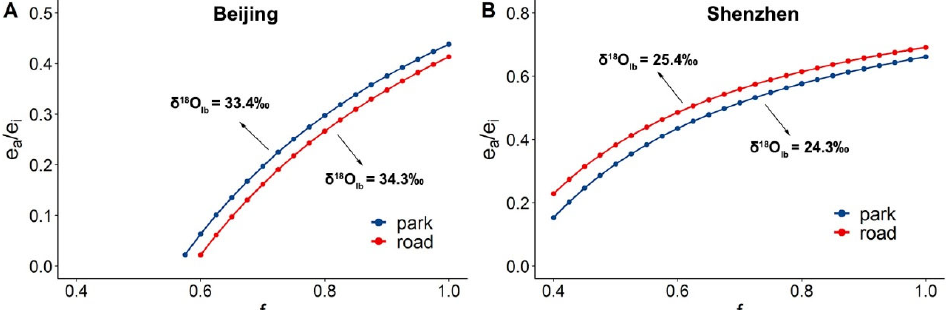
Figure 6. Relationship between δ 18 O in leaves and e a /e i under different green land types ( A ) P. tomentosa leaves in Beijing ( B ) F. virens leaves in Shenzhen. The e a /e i was calculated based on mean δ 18 O values in source water and leaves. The text in the figure shows the mean δ 18 O values in the leaves under different green land types used in Equation (3).